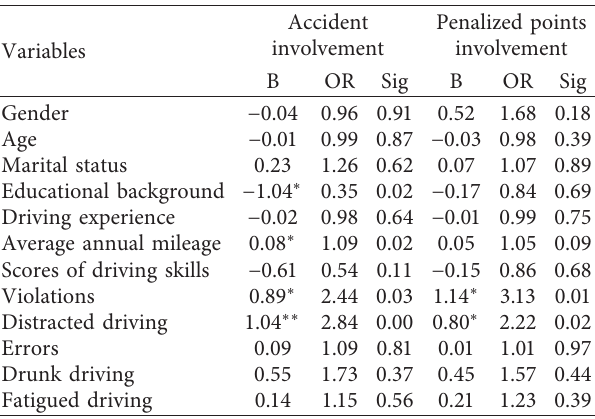
Table 5: Variables associated with risk